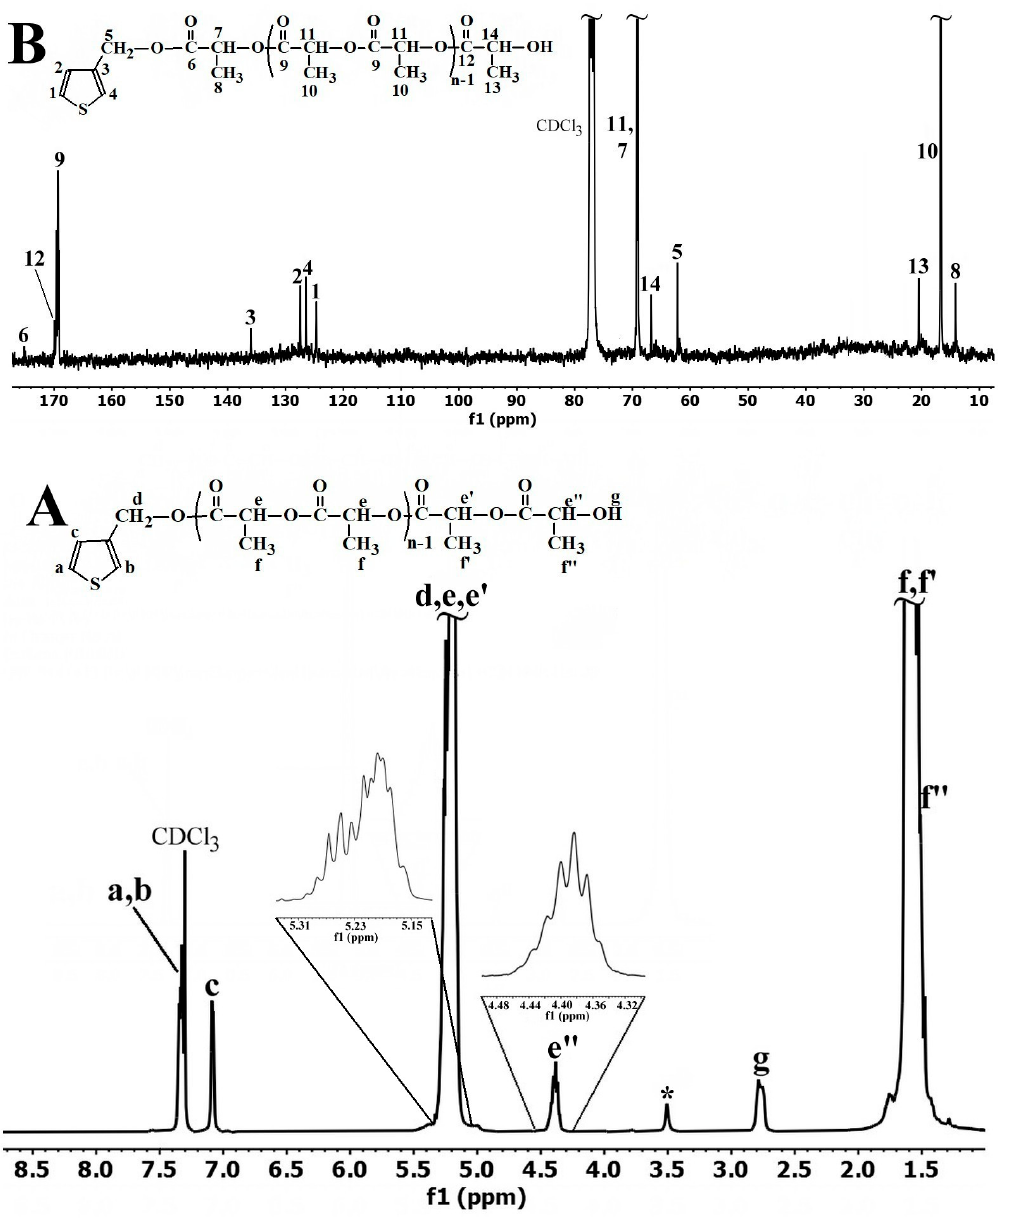
Figure 1. ( A ) 1 H-NMR and ( B ) 13 C-NMR spectrum of Th-PDLLA registered in CDCl 3 (with * were denoted the impurities, possible traces of methanol).